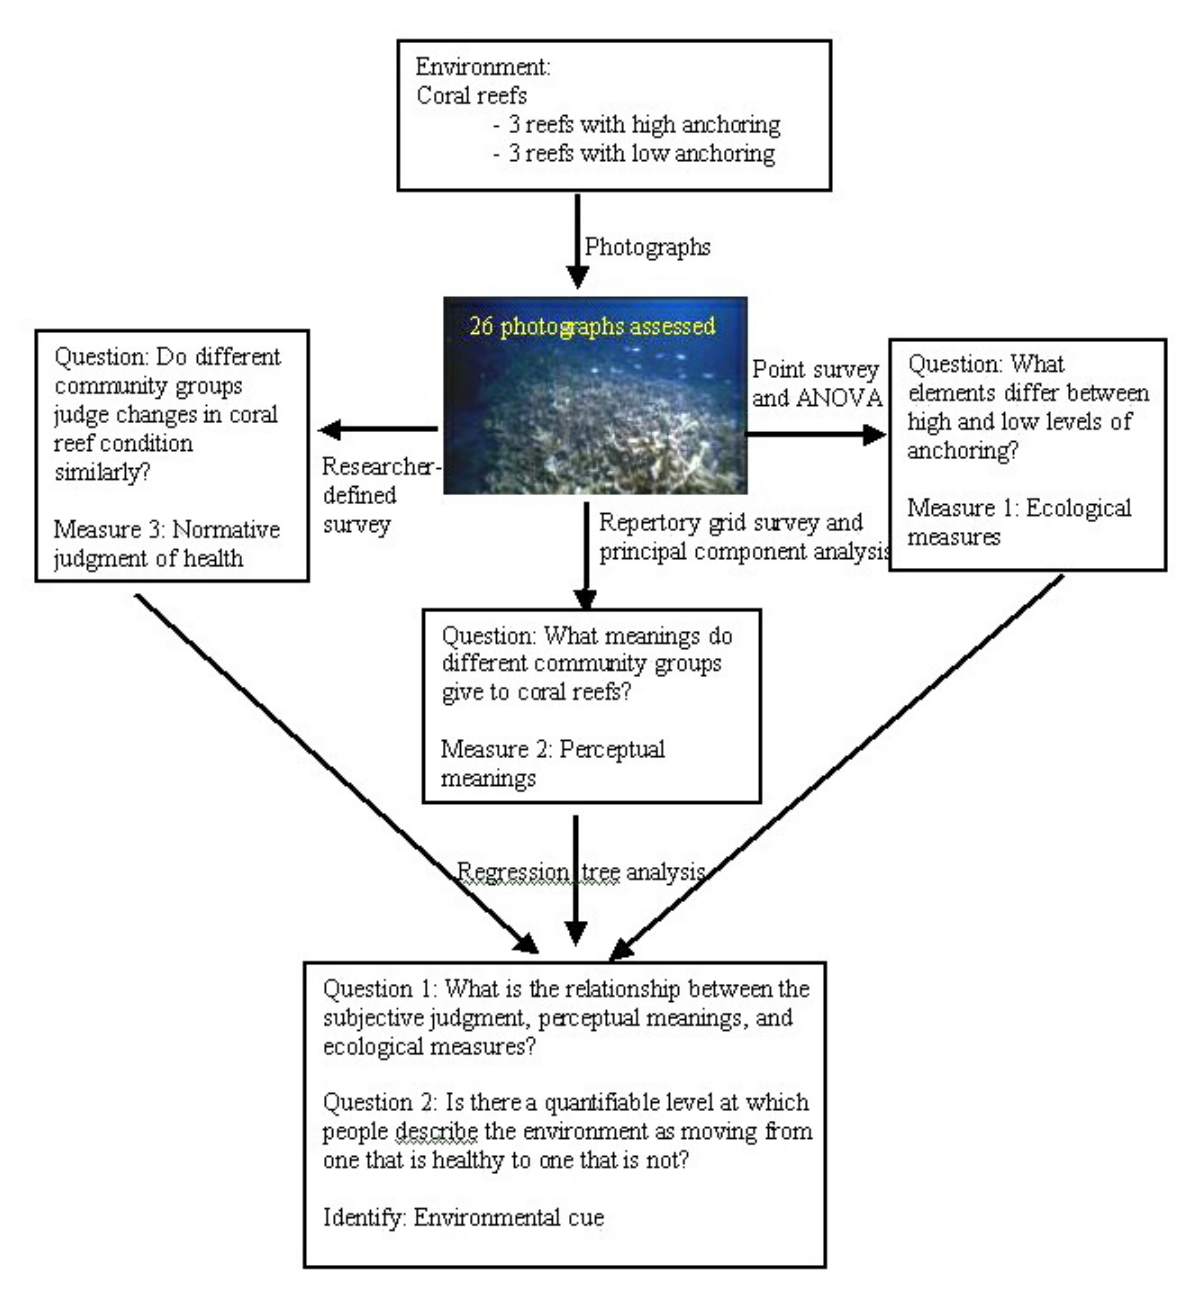
Fig. 1 . An outline of the method used to link the ecological measures, perceptual meanings, and health judgments of coral reefs associated with high and low intensities of